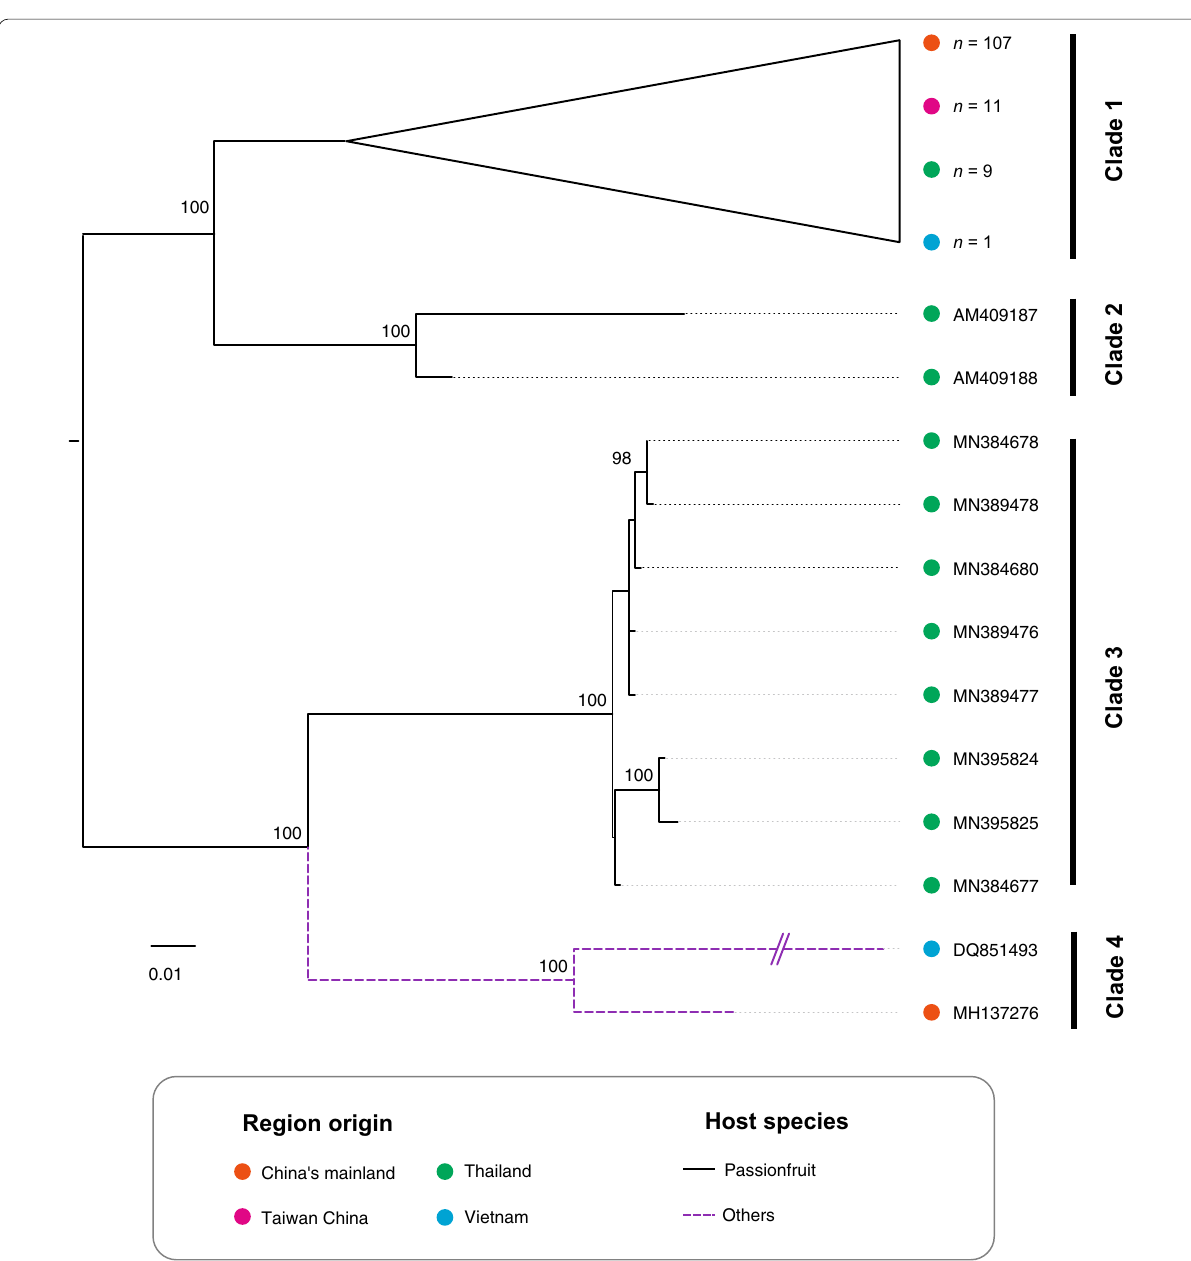
Fig. 2 Maximum-likelihood phylogenetic tree based on the nucleotide sequences of the coat protein gene of TelMV. Ultrafast bootstrap support > 95% values are given at each node. The bar represents the number of substitutions per